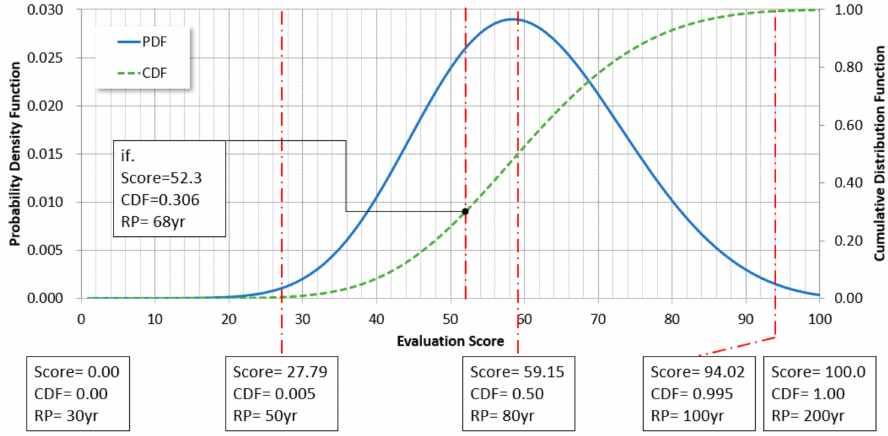
Figure 3. GEV probability distribution for evaluation